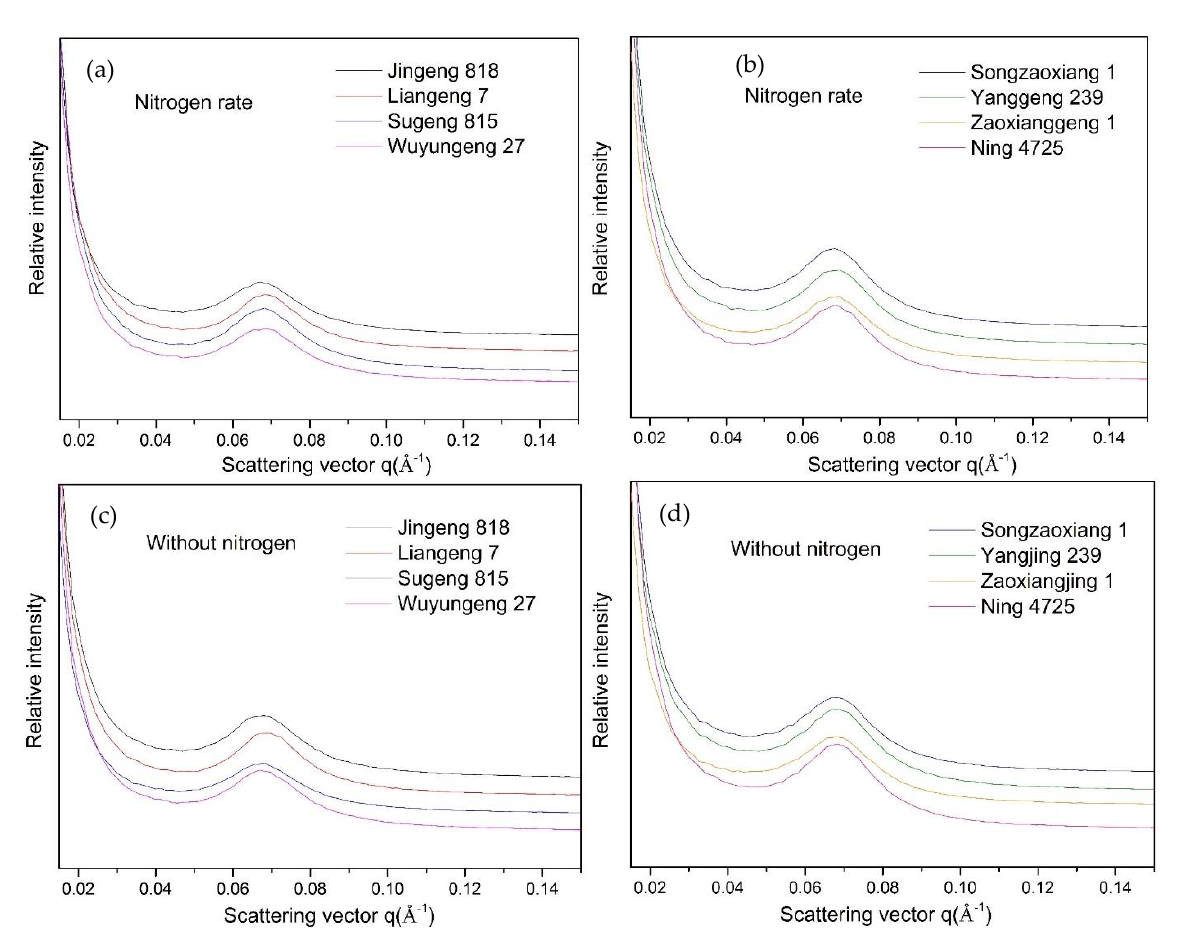
Figure 3. Small-angle X-ray scattering spectra of the starch of japonica rice cultivars with different contents of amylose, with or without nitrogen fertilization. ( a ) NAC, with fertilization; ( b ) LAC, with fertilization; ( c ) NAC, without fertilization; ( d ) LAC, without fertilization.